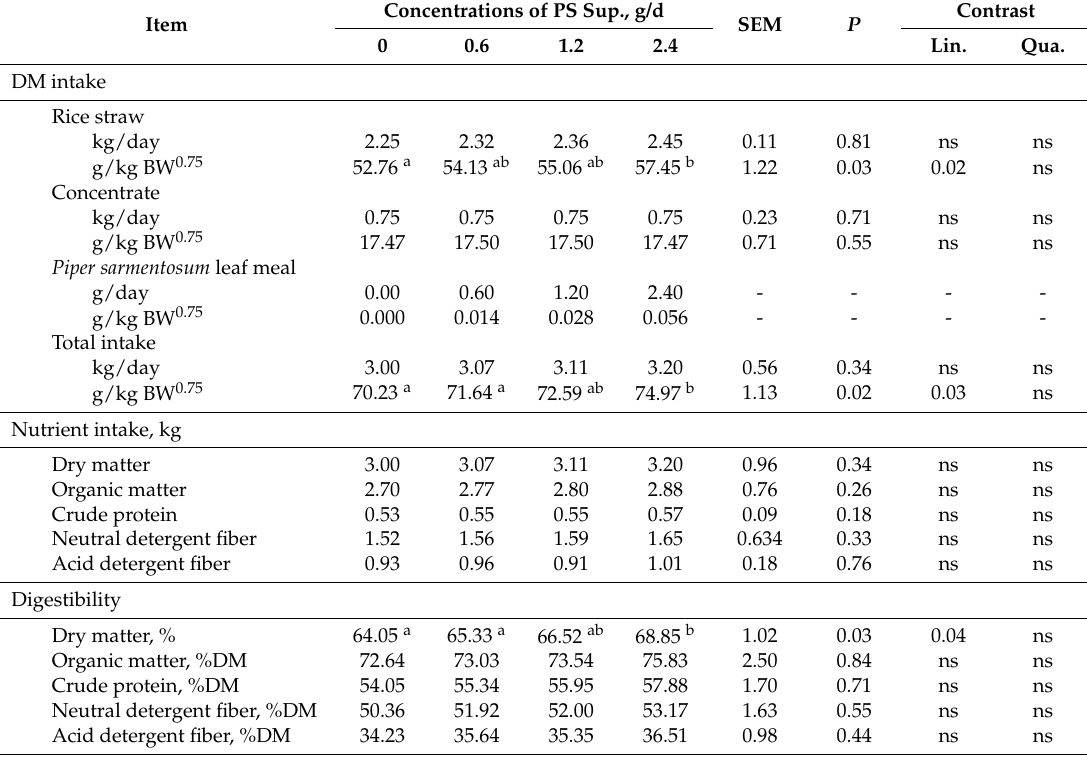
Table 2. Effect of supplementation of Piper sarmentosum (PS) leaf meal on feed used and nutrient digestibility in